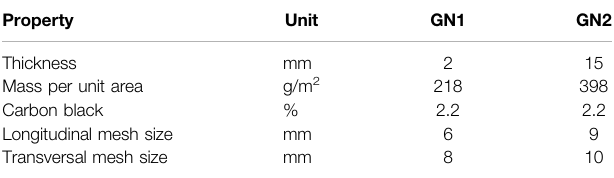
TABLE 1 | Typical speci fi cations for